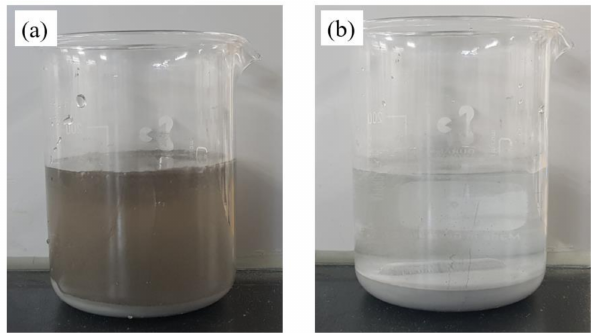
Figure 1. Di ff erence in colors of solution ( a ) before coating of graphene oxide (GO) on aluminum (Al) particles (brown solution) and ( b ) after deposition of Graphene encapsulated Al powder (Al / GO) composites particles (clear